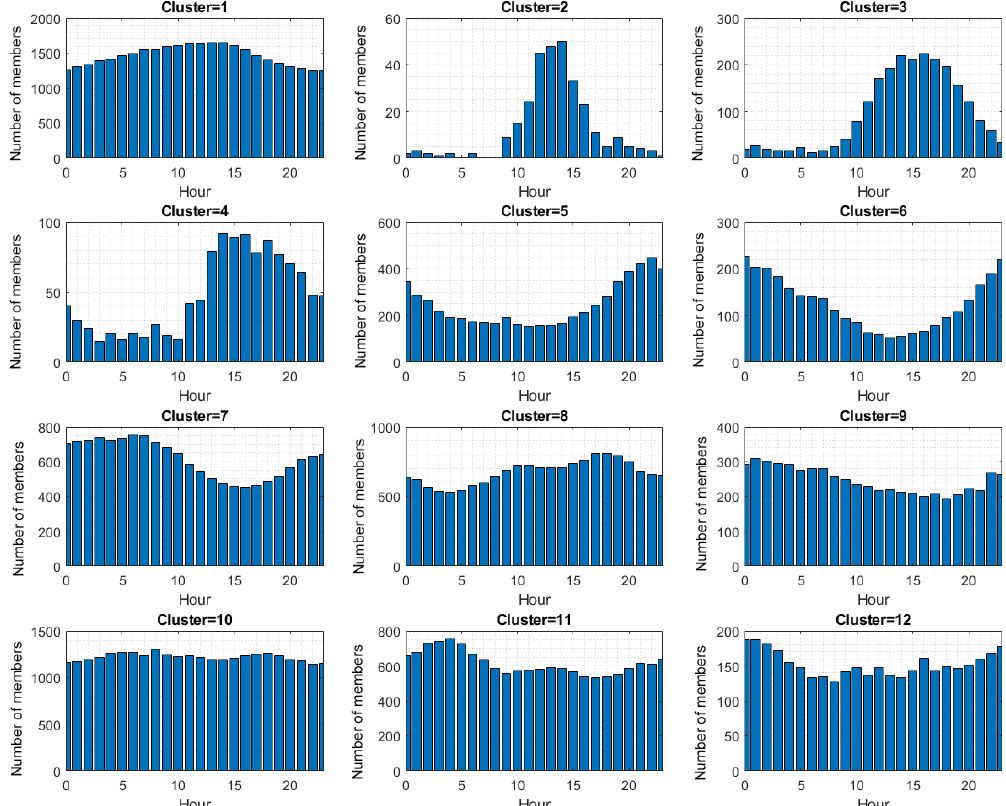
Figure 5. Diurnal variability of clusters 1–12. Panels indicate the number of cluster members observed at a given time of day